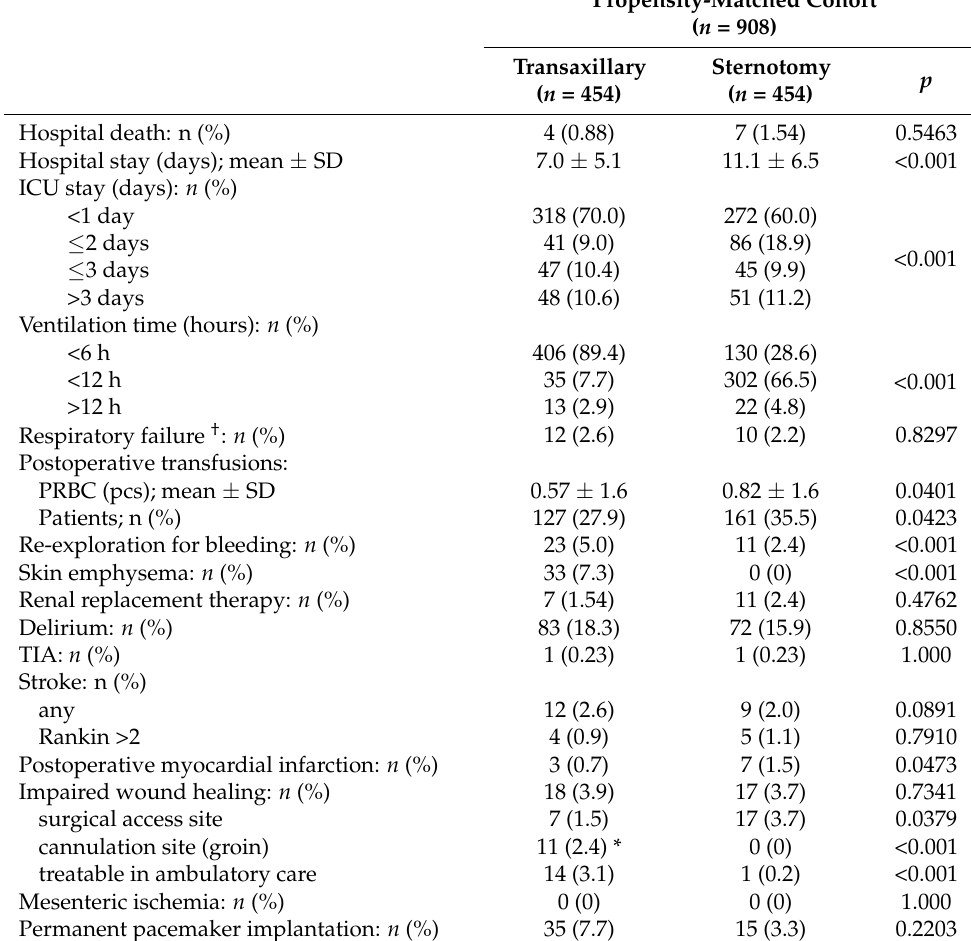
Table 4. Postoperative